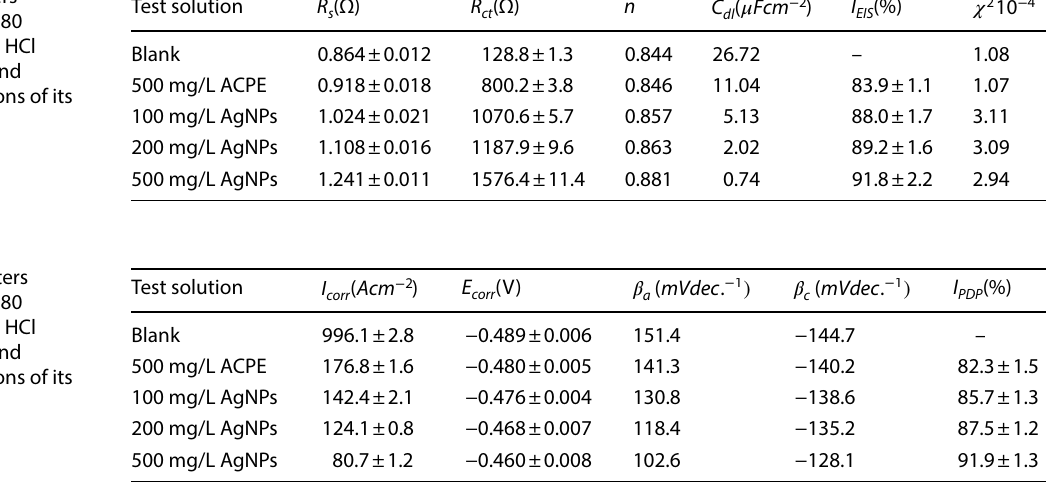
Table 1 EIS parameters for the inhibition of X80 steel corrosion in 1 M HCl containing Et-ACPE and different concentrations of its Et-AgNPs